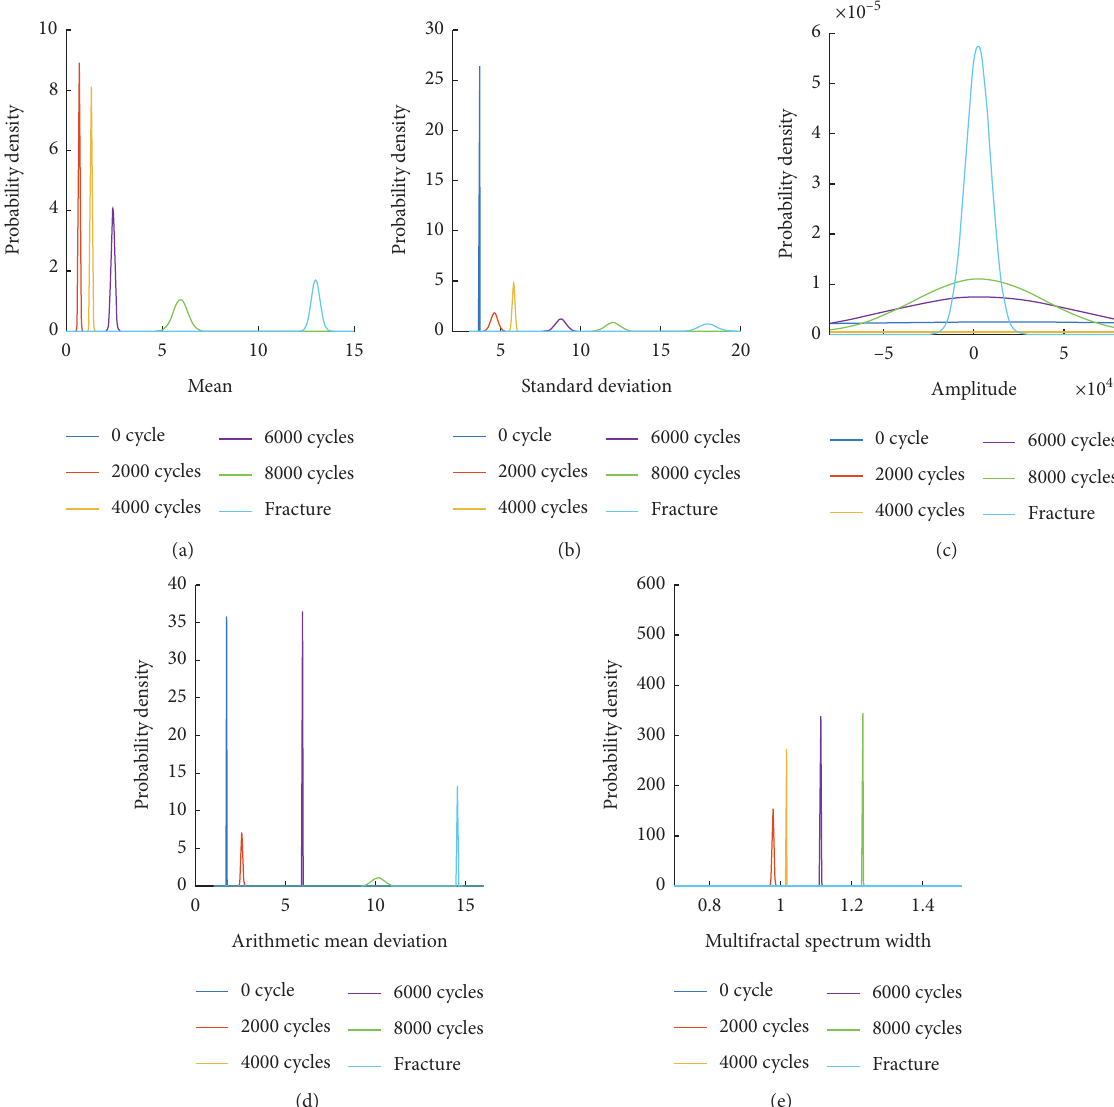
Figure 15: The priori probability distribution of each characteristic parameter under different cycles. (a) μ . (b) δ . (c) A . (d) S